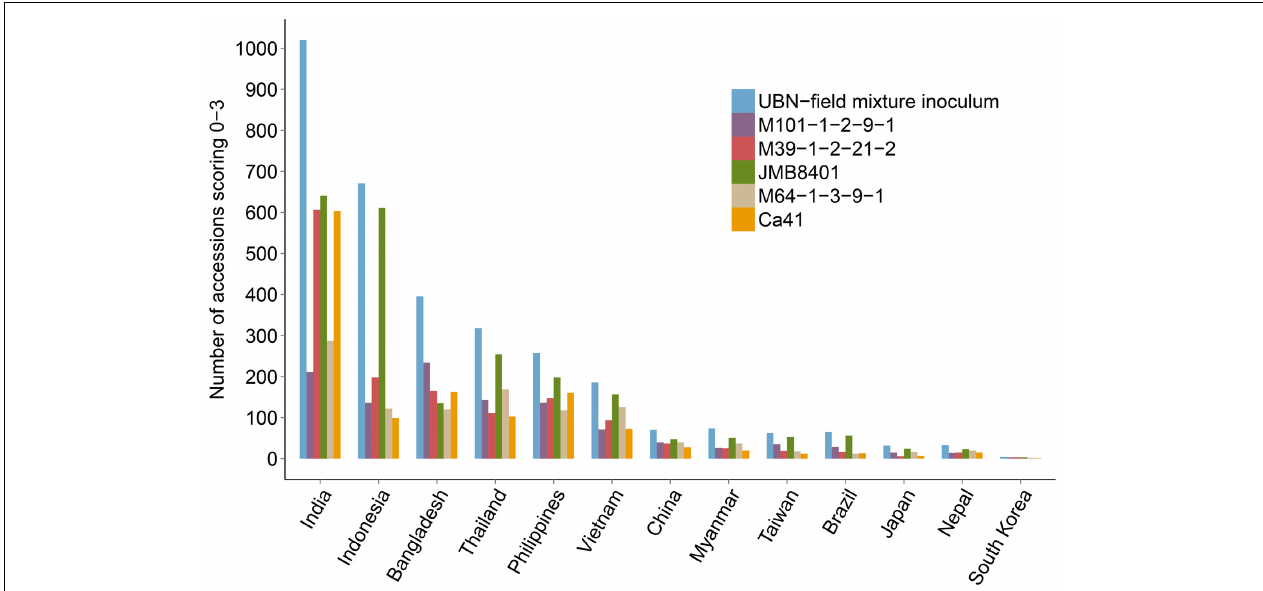
FIGURE 3 | Isolate specific screening of UBN resistant rice genotypes. UBN-resistant accessions (score 0–3) were screened against five different single rice blast isolates under controlled conditions. Data for accessions exhibiting resistance against particular isolates is shown, with different color bars representing each isolate. It should be noted